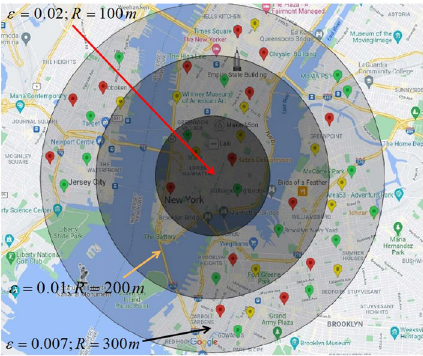
Figure 5. The optimized effect of perturbation region on the basis of Fig. 4. Geo-information obtained via Google Maps (https:// www. google. com/ maps, Latitude: 40.7185036, Longitude: − 73.9648126, Elevation: 13.02) and POI with different semantic information have been marked manually with different